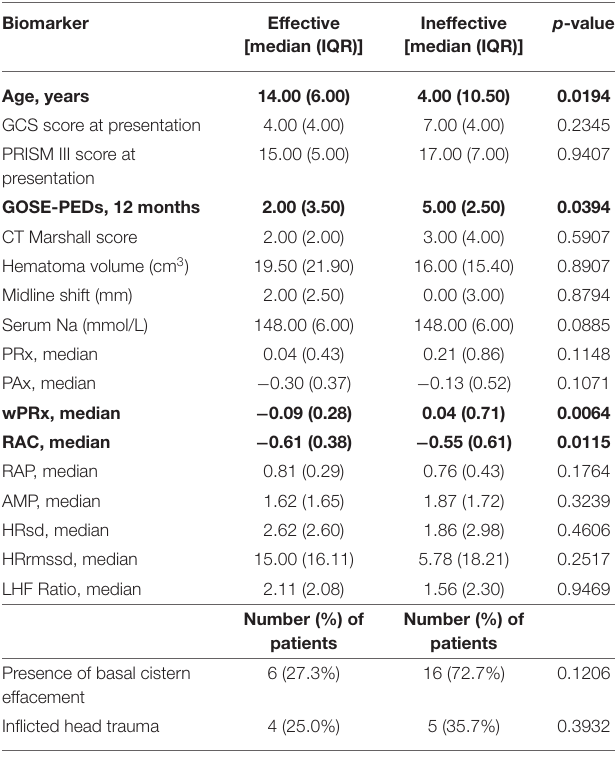
TABLE 2 | Pre-treatment characteristics associated with reduction of intracranial hypertension after hyperosmolar therapy. Biomarker